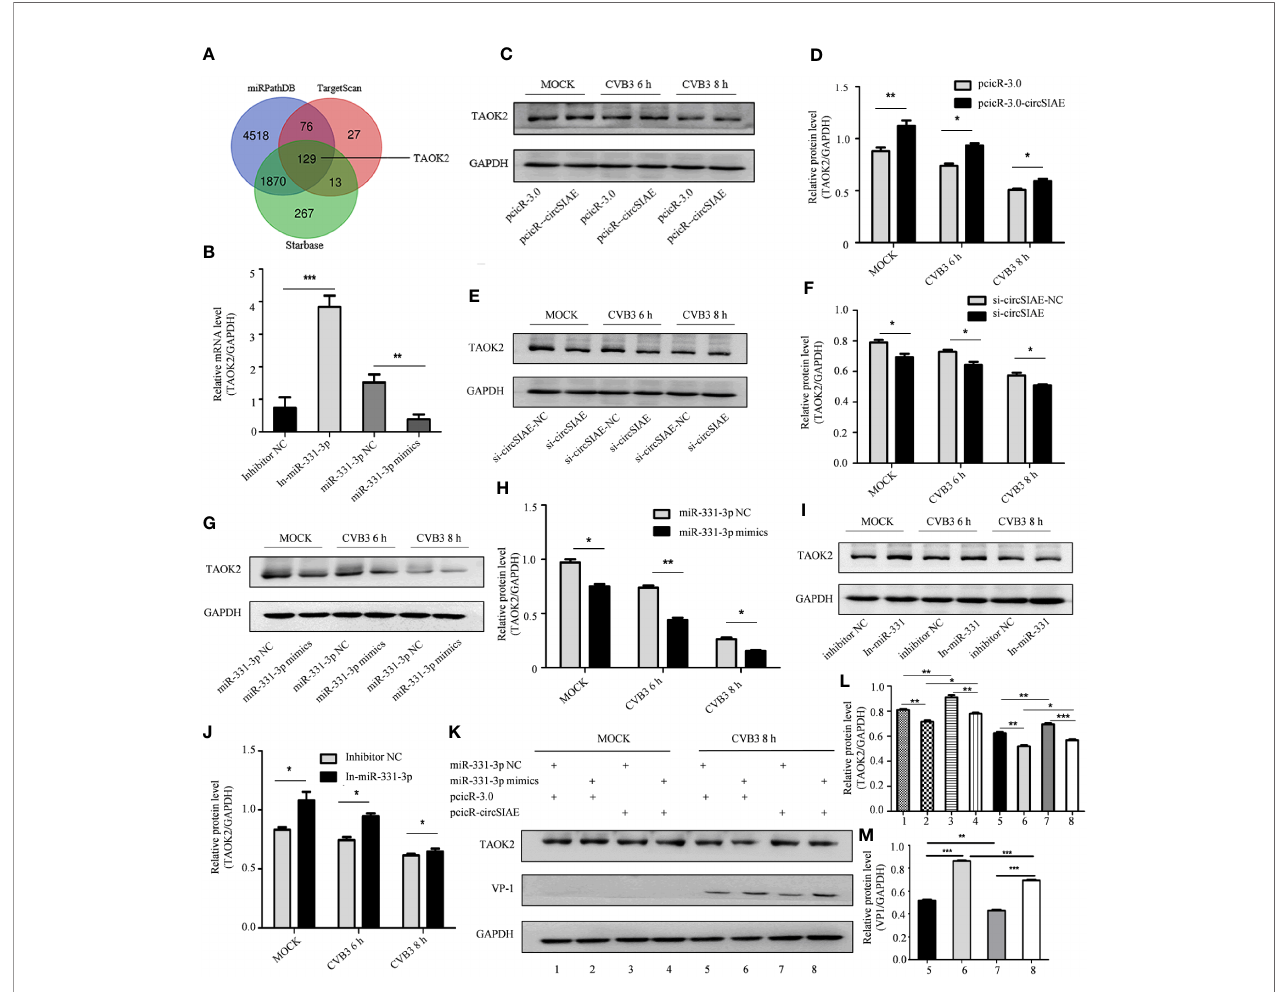
FIGURE 5 | Searching for downstream target genes of miR-331-3p. (A) Downstream target genes of miR-331-3p were identi fi ed by database screening. (B) Total RNA was extracted after transfection with miR-331-3p mimics/inhibitor for 36 h, and the expression level of TAOK2 was veri fi ed by qRT-PCR. (C, E, G, I) After circSIAE and miR331-3p were overexpressed/knocked down in HeLa cells, the relationship between circSIAE/miR-331-3p and TAOK2 was veri fi ed by Western blotting and qRT-PCR analysis. (D, F, H, J) The protein levels were quanti fi ed by densitometric analysis using ImageJ. (G, K) Total protein of HeLa cells was extracted after co-transfection of pcicR-3.0-circSIAE and miR-331-3p mimics, and cells were then infected with CVB3 for 8 h, and protein changes of TAOK2 and VP-1 were determined by Western blot. (L, M) The protein levels of fi gures of (J, K) were quanti fi ed by densitometric analysis using Image J. *p < 0.05, **p < 0.01, ***p <